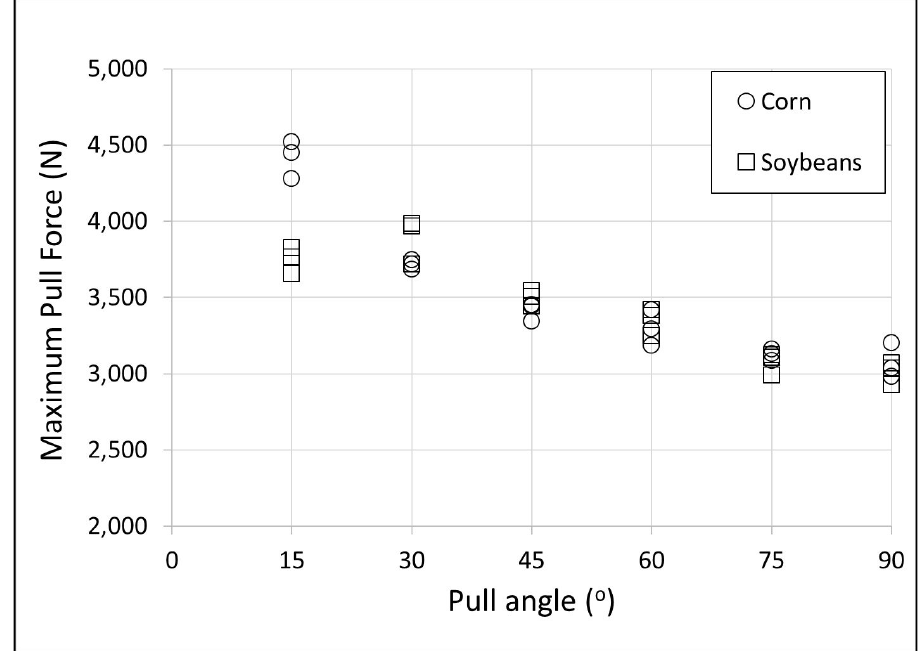
Figure 4. Maximum pull-force (in newtons) required to extricate the mannequin at various angles at a 1.8 m depth in corn (circle) and soybeans (square).